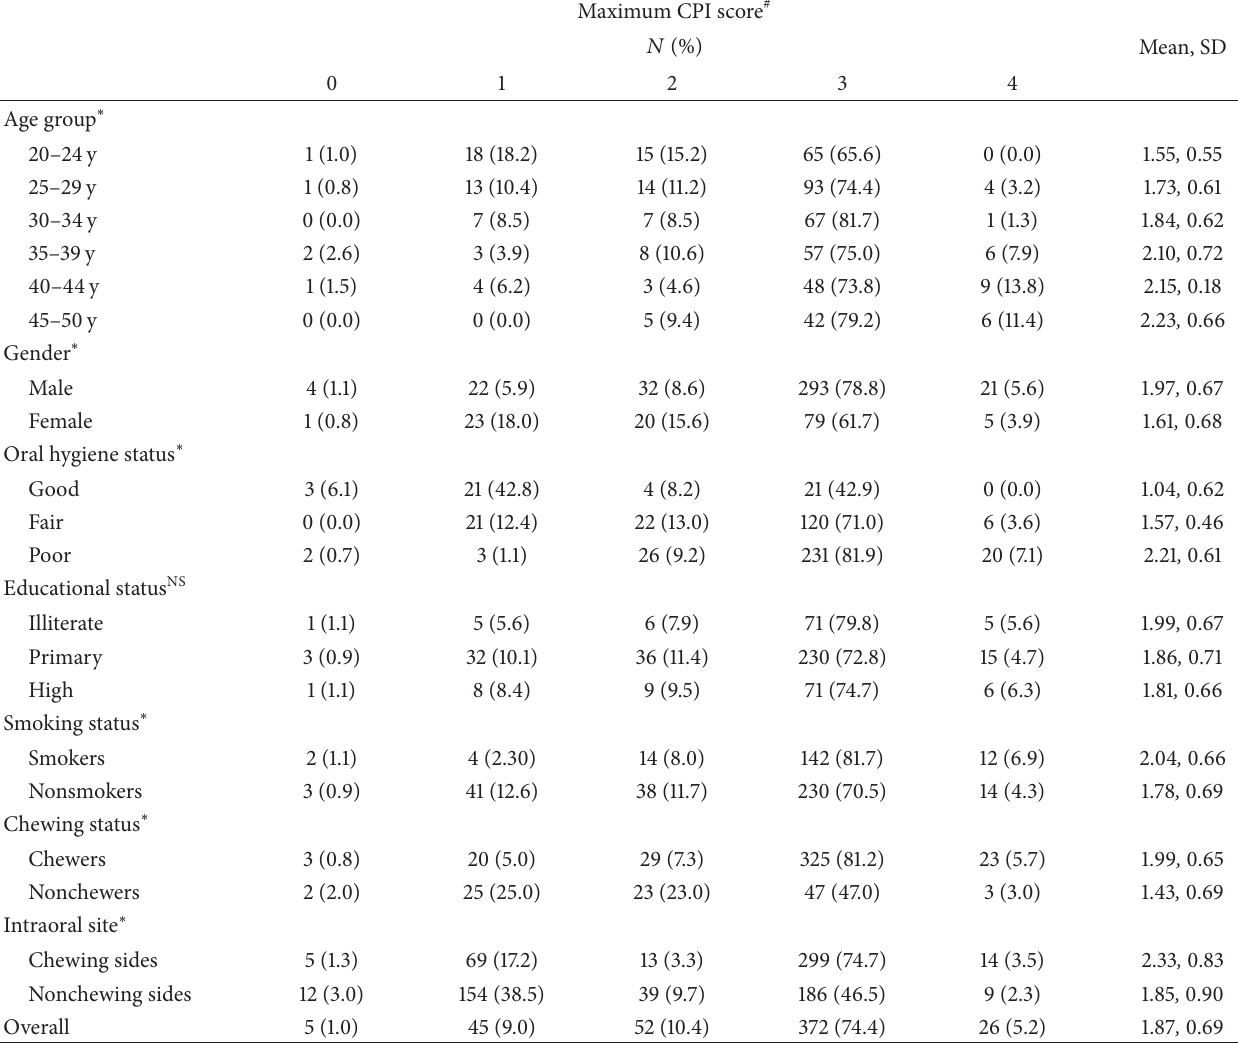
Table 2: Descriptive statistics of CPI scores by risk